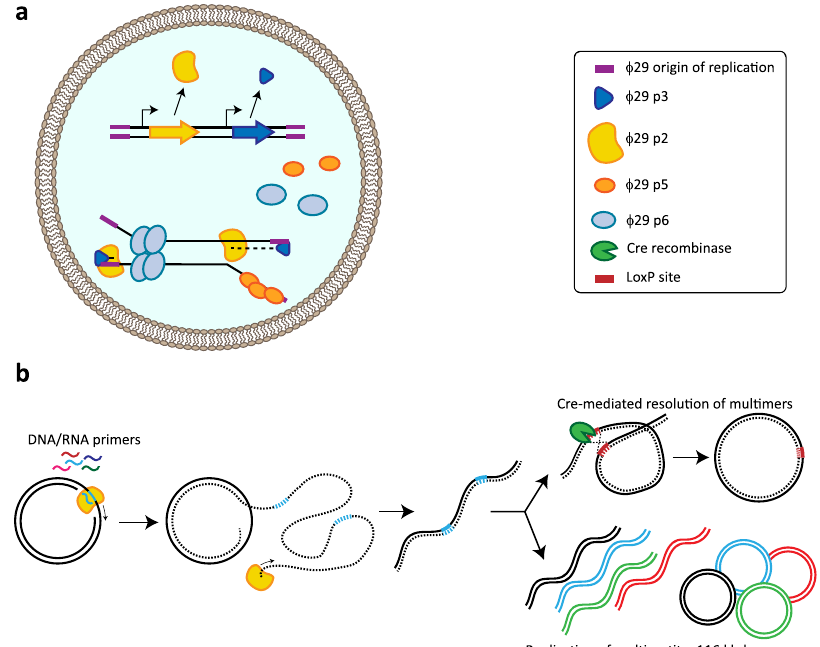
Fig. 2 Synthetic DNA replication. Implementation of the bacteriophage ϕ 29 system for DNA replication in in vitro transcription-translation (IVTT) reactions. a The reconstitution of the complete ϕ 29 DNA replication machinery has been demonstrated inside a synthetic liposome. Bi-directional self- replication of a linear DNA has been achieved, with the linear DNA template encoding the DNA-polymerase (DNAP, protein p2) and the Terminal protein (p3), which binds to the origin of replication at the end of the linear fragment and provides an hydroxyl group to prime DNA-polymerisation. The single- stranded DNA-binding protein (p5) and the origin-binding protein (p6), promoting the unwinding of the phage origin of replication, were supplemented as puri fi ed proteins 14 . b ϕ 29 DNAP-mediated rolling-circle ampli fi cation of circular dsDNA molecules, resulting in a linear dsDNA multimer 15 . The synthetic multimer can be re-converted into circular DNA monomers through Cre-Lox recombination 16 (top). In a ϕ 29 DNAP-based replication experiment using a multipartite genome 17 (bottom right), spontaneous monomerisation, disentangling and circularisation was observed, notably resulting in a mixture of linear multimers and circular monomers 17